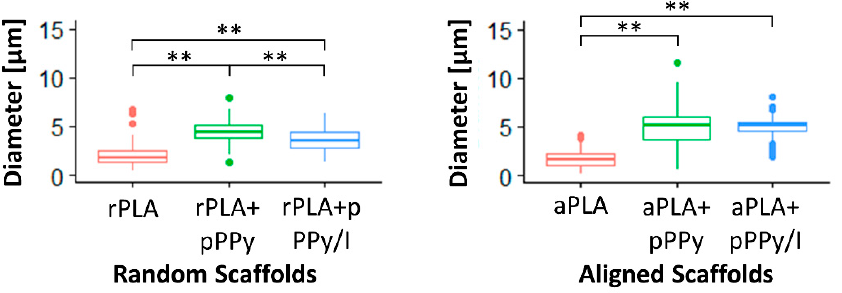
Figure 9. Boxplot of fiber diameter distribution. Statistical differences with the Dunn (1964) Kruskal–Wallis multiple comparison test, ** p < 0.01.